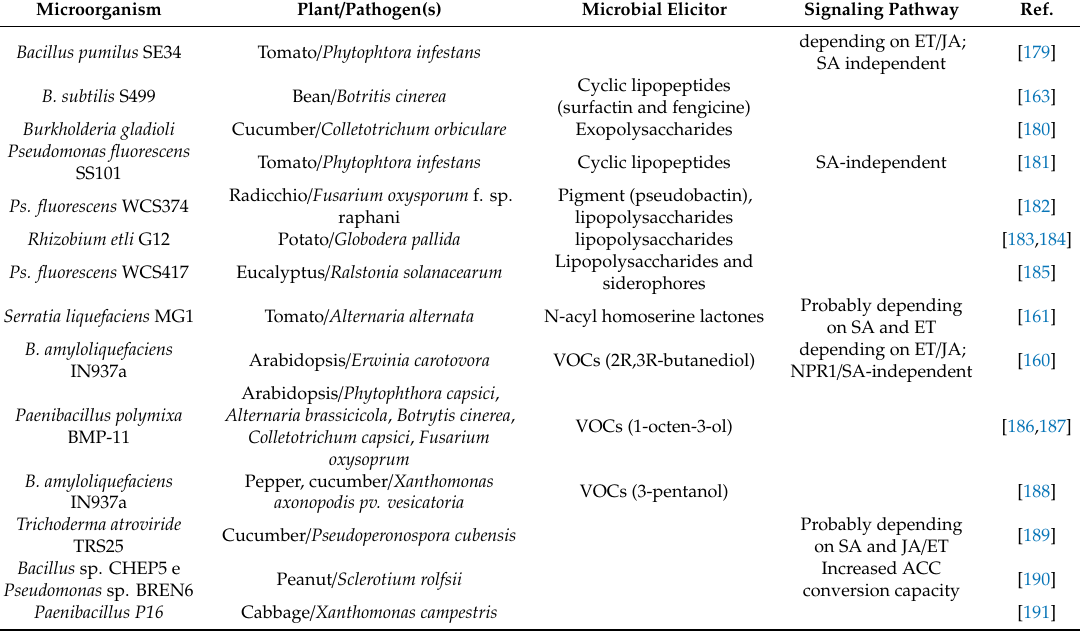
Table 3. Resistance-inducing microorganisms with their respective plant protection